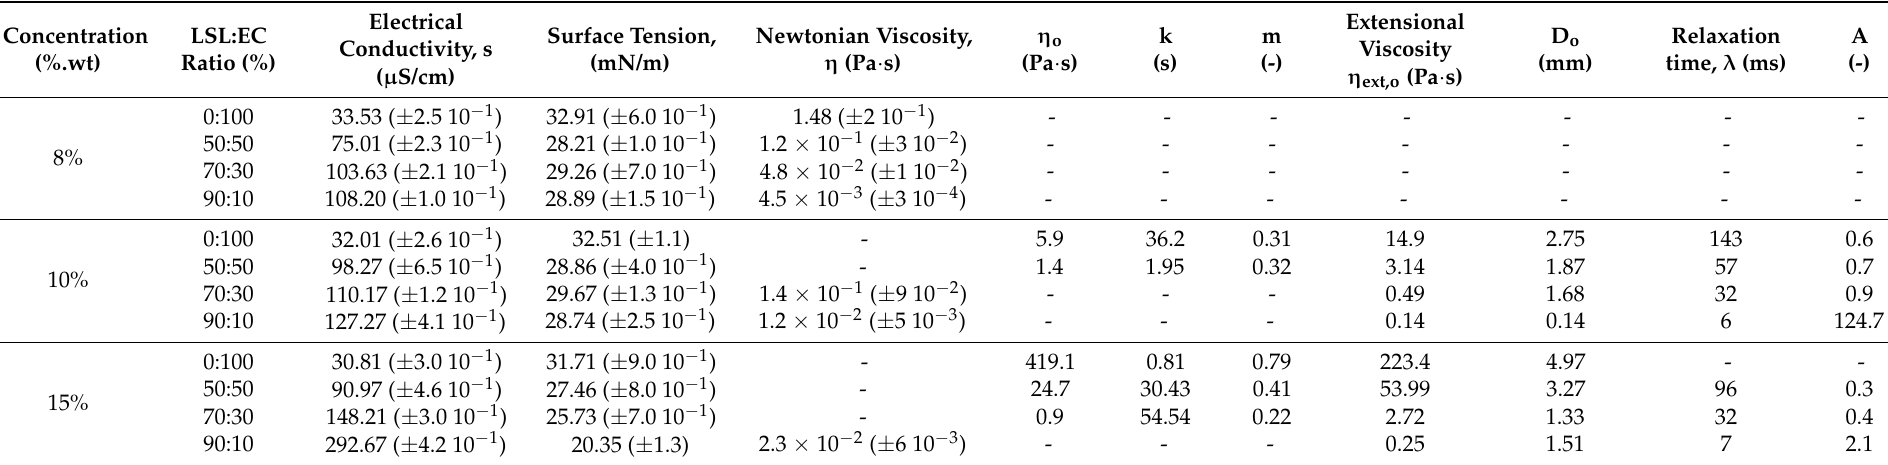
Table 1. Electrical conductivity, surface tension, and shear and extensional viscosity of LSL:EC solutions in THF:DMAc.